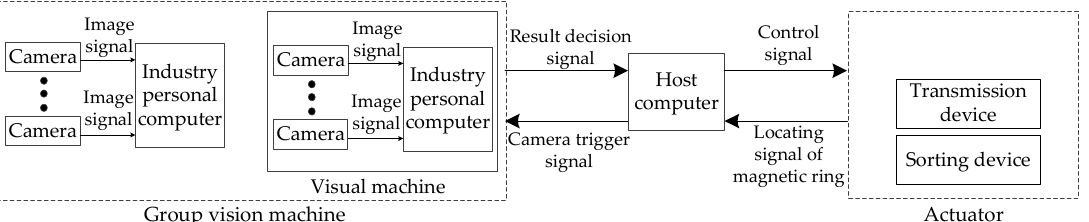
Figure 2. Structural diagram of the magnetic ring detection system.